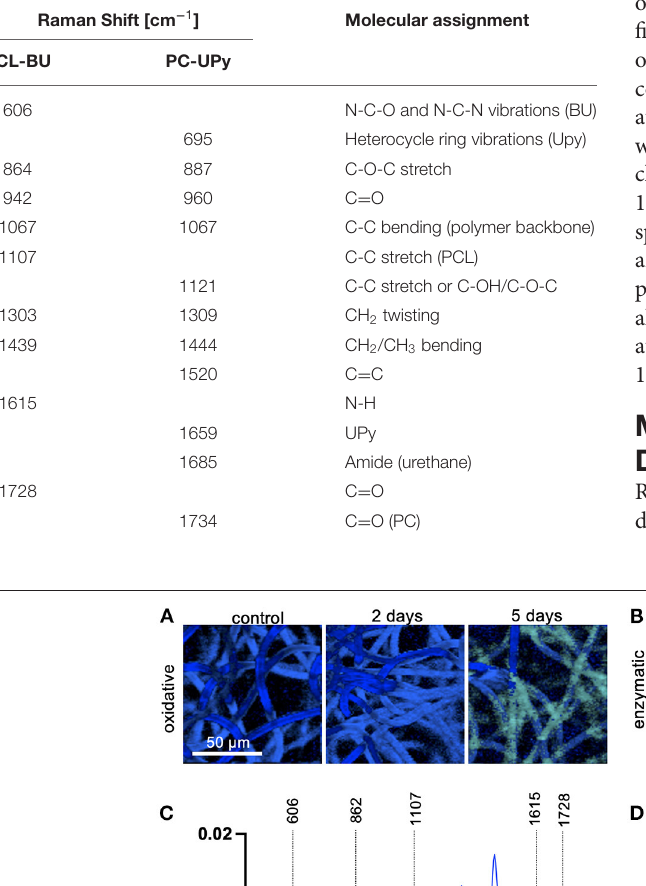
TABLE 1 | Relevant PCL-BU and PC-UPy peaks and their molecular assignments.